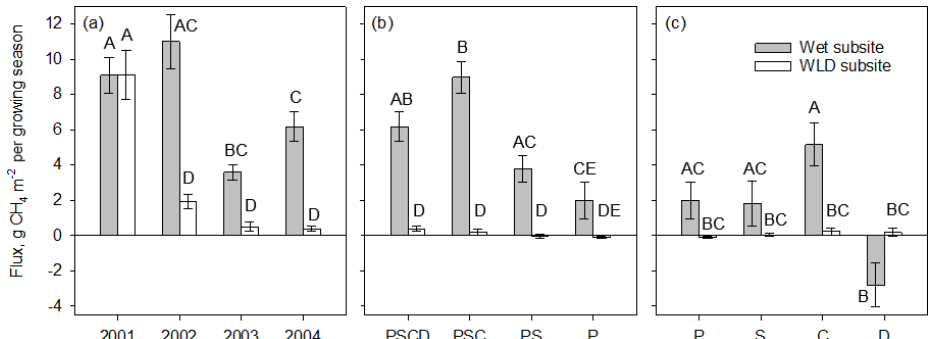
Figure 3. Seasonal (June–September) CH 4 flux (mean ± 1 standard error) at wet and water level (WLD) drawdown subsites (a) in plots with intact vegetation (PSCD) during the 4 study years (2001 was a calibration year before the implementation of the WLD treatment), (b) in different plant removal treatments plots in 2004, and (c) by each plant group, the contribution of which to the total flux in 2004 was estimated from differences between the different plant removal treatments. Letters above bars denote differences among treatments, where bars with no letter in common are significantly different based on a mixed-effect models presented in Table 2 (a, b) and based on two-way ANOVA test with Tukey pairwise comparisons (c) . Plant removal treatments in (b) : PSCD – plots with intact vegetation, consisting of peat, Sphagnum mosses, sedges, and shrubs; PSC – plots consisting of peat, Sphagnum mosses, and sedges (shrubs removed); PS – plots consisting of peat and Sphagnum mosses (shrubs and sedges removed); P – plots consisting of bare peat (all vegetation removed). Plant groups in (c) : P – bare peat; S – Sphagnum mosses; C – sedges; D – dwarf